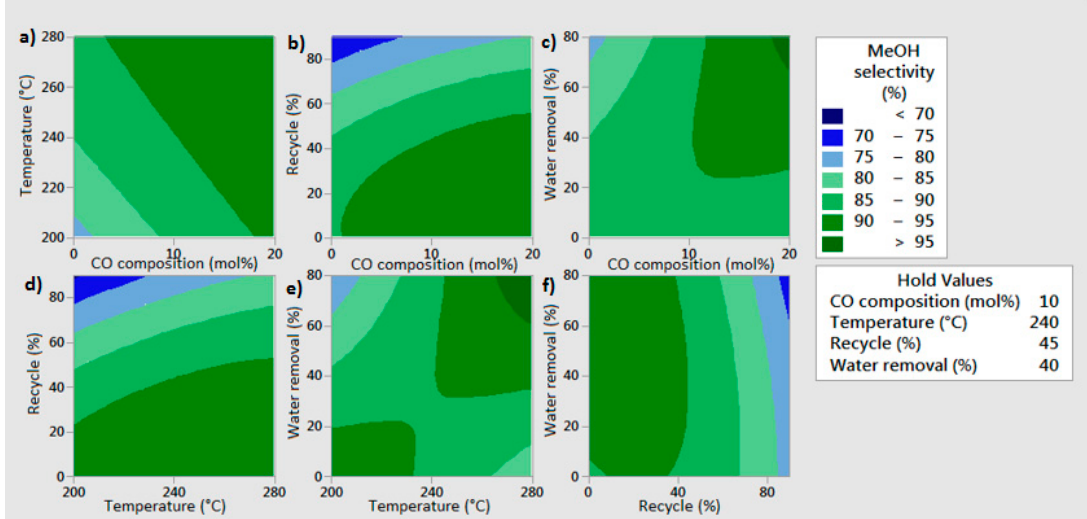
Figure 11. Surface plots of methanol selectivity obtained by CCD analysis: ( a ) methanol selectivity as function of temperature and CO composition in the feed; ( b ) methanol selectivity as function of recycle and CO composition in the feed; ( c ) methanol selectivity as function of water removal and CO composition in the feed; ( d ) methanol selectivity as function of recycle and temperature; ( e ) methanol selectivity as function of water removal and temperature; ( f ) methanol selectivity as function of water removal and recycle.